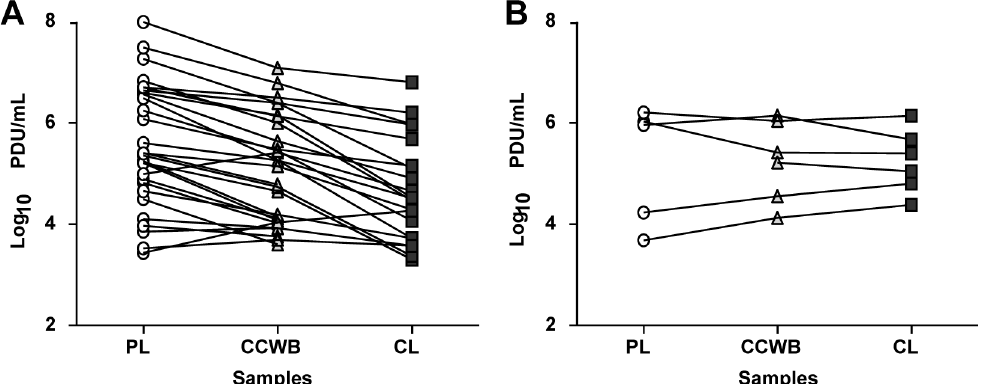
Fig 3. Linked comparison of DENV viral loads in blood components including clots. A) DENV-1 and DENV-4 combined viral loads in plasma (PL), the cellular component of whole blood (CCWB) and clot (CL), n = 29 samples. B) DENV-1 and DENV-4 combined viral loads in plasma (PL), the cellular component of whole blood (CCWB) and fresher clot (CL), n = 6 samples.